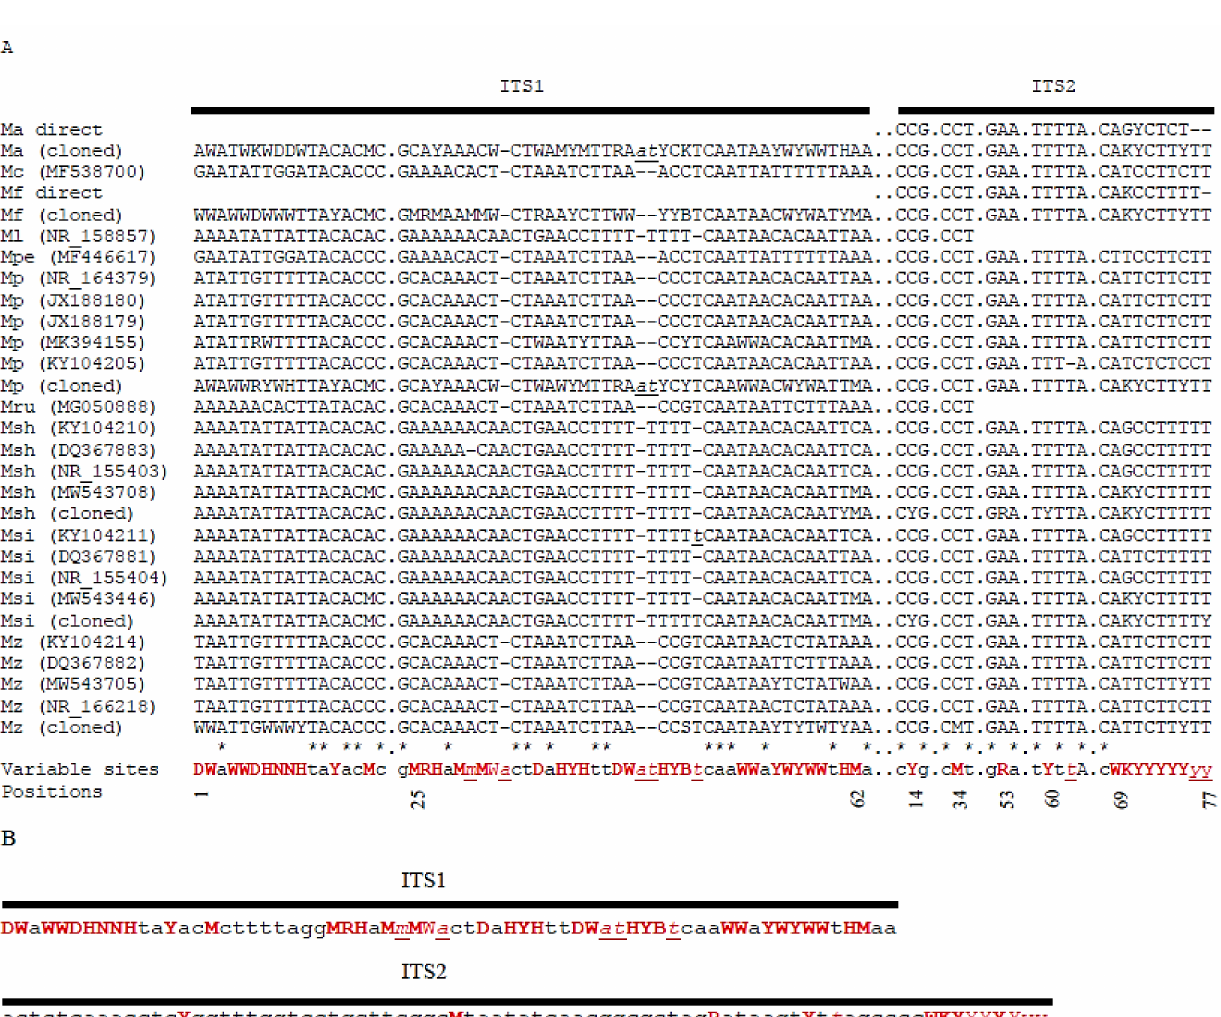
Figure 5. Comparison of the ITS sequences of the pulcherrima clade. ( A ) Multiple alignment of variable segments. Only examples of the database type-strain sequences are shown (GenBank accession numbers are given in parenthesis). Direct: sequence obtained in this study by direct sequencing of the PCR amplicon. The cloned sequences are consensus sequences of clones. Numbering of the positions corresponds to that of the M. pulcherrima sequence NR_164379. Ma: M. andauensis ; Mc: M. citriensis ; Mf: M. fructicola ; Ml: M. leonuri ; Mpe: M. persimmonesis ; Mpu: M. pulcherrima ; Mr: M. rubicola ; Msh: M. shanxiensis ; Msi: M. sinensis ; Mz: M. zizyphicola ; M: A or C; R: A or G; Y: C or T; V: A or C or G; W: A or T. Nucleotide symbols are lower-case and underlined at positions in which indels or insertions occur. ( B ) Consensus sequences of the entire ITS1 and ITS2 segments. Variable positions are highlighted with red